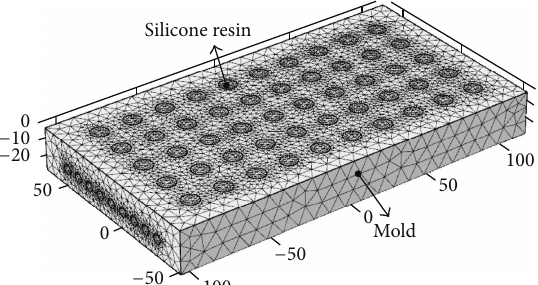
Figure 7: F.E. model for LED lens